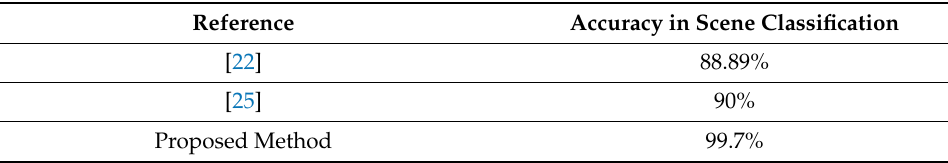
Table 4. Comparison of accuracies of different